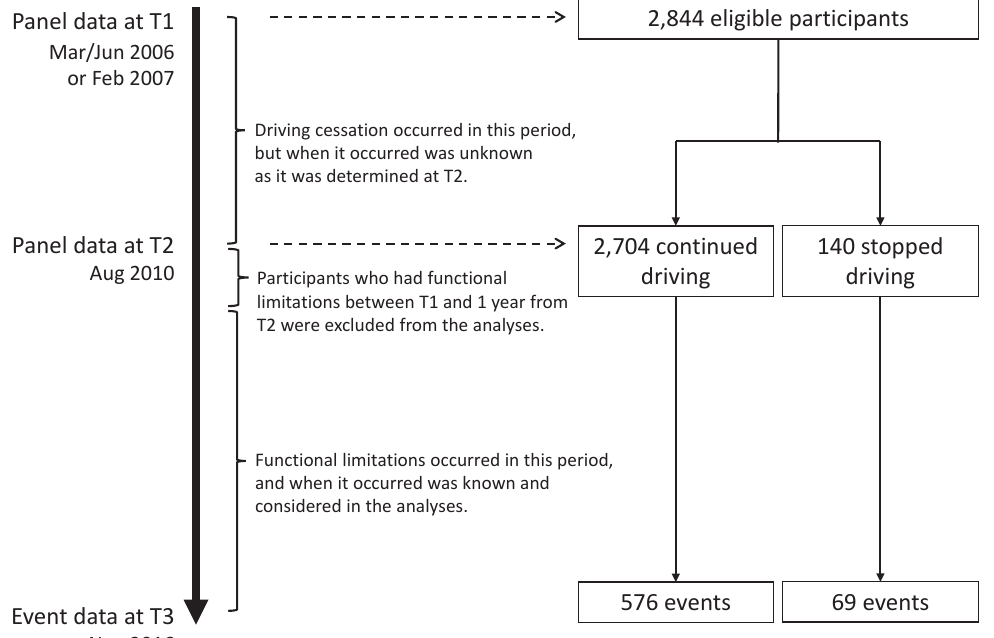
Figure 1. Flow chart of data collection and